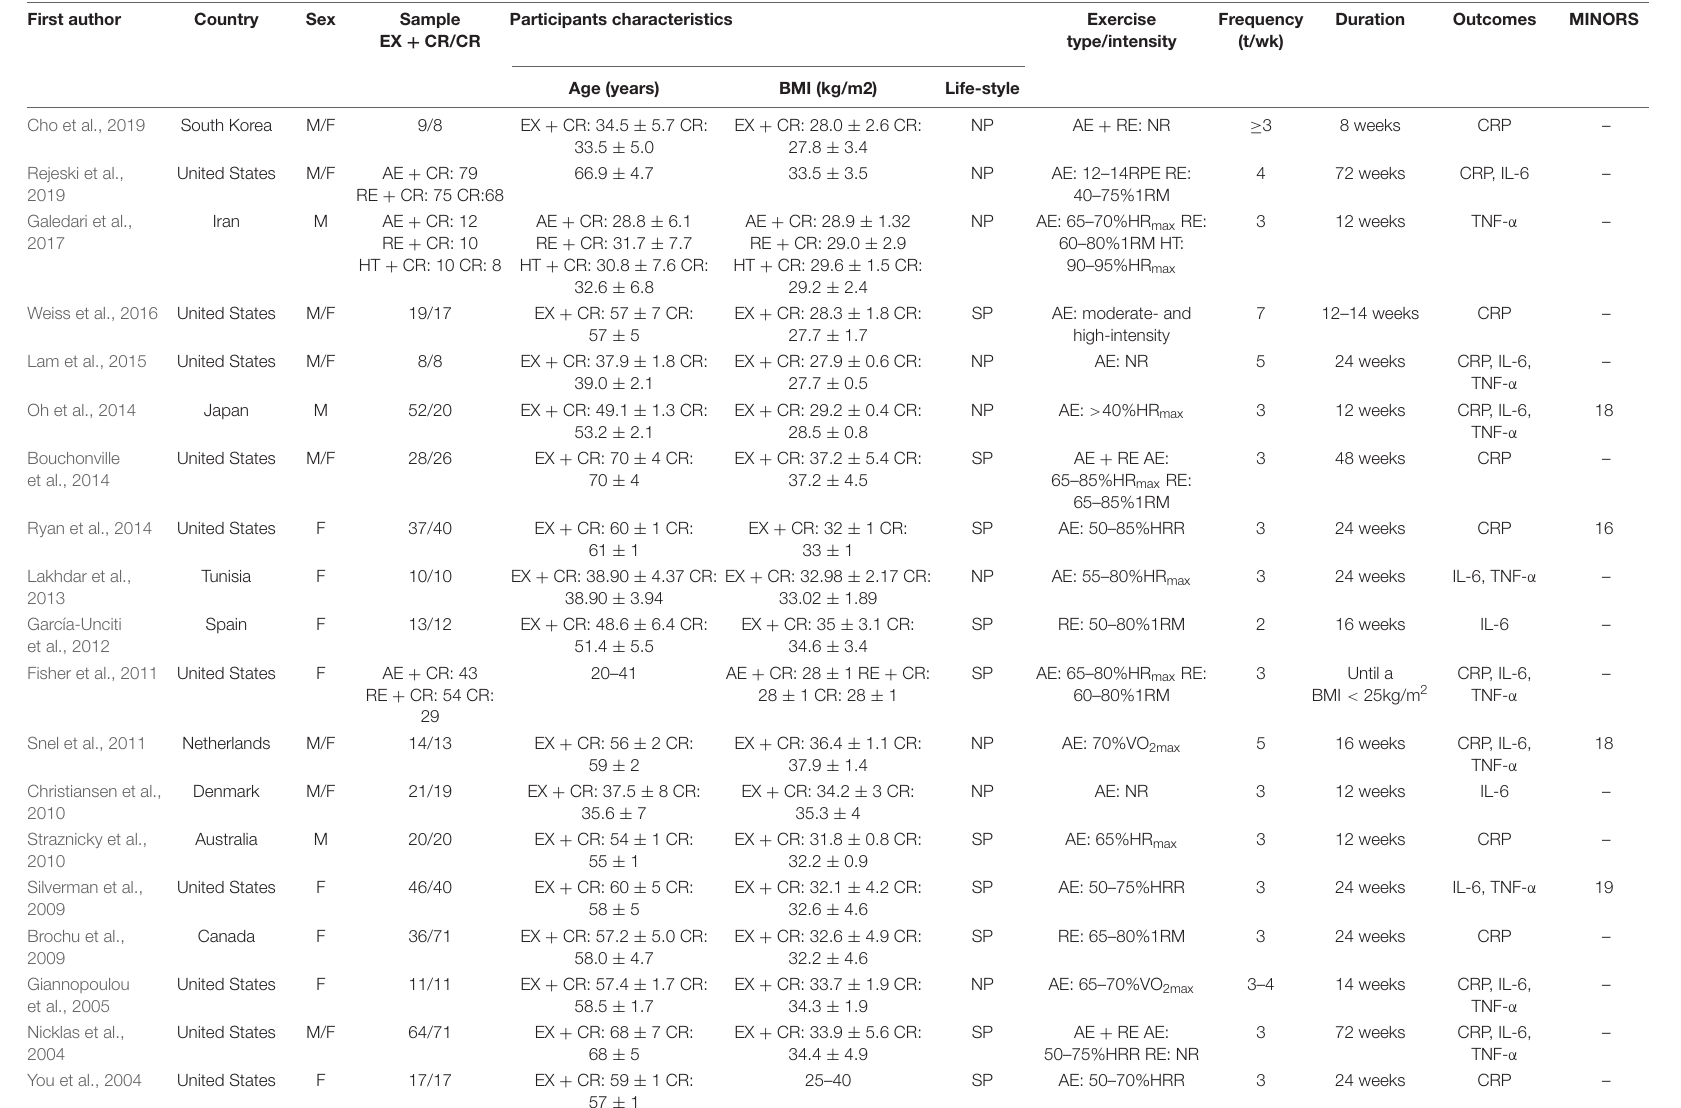
TABLE 1 | Characteristics of the included studies, presented in chronological